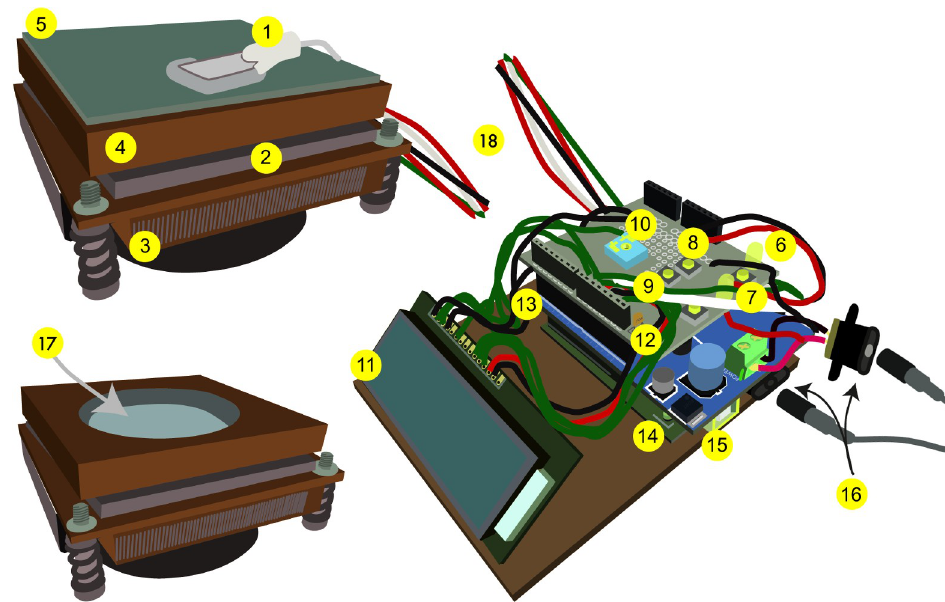
Fig 1. Device overview. (1) Thermistor. (2) Thermoelectric cooler (TEC). (3) Fan-controlled CPU heatsink. (4) Solid copper heatsink. (5) Mirror. (6) PID indicator light, which increases in intensity as more energy is drawn to heat or cool the stage. (7) Reset button. (8) Setpoint temperature + button. (9) Setpoint temperature–button. (10) Potentiometer, which adjusts the intensity of the LCD screen. (11) LCD screen. (12) Protoshield (top board). (13) Bi- directional motor driver shield (middle board). (14) Arduino microcontroller (bottom board). (15) USB port. (16) Power supply ports and cables; the two power supplies can be plugged into a power strip (not shown), and the device powered on or off using the power strip switch. (17) Alternate heatsink with a well for a petri plate. (18) Wires connecting the microcontroller unit and the heatsink unit on which the specimen is mounted can be of any